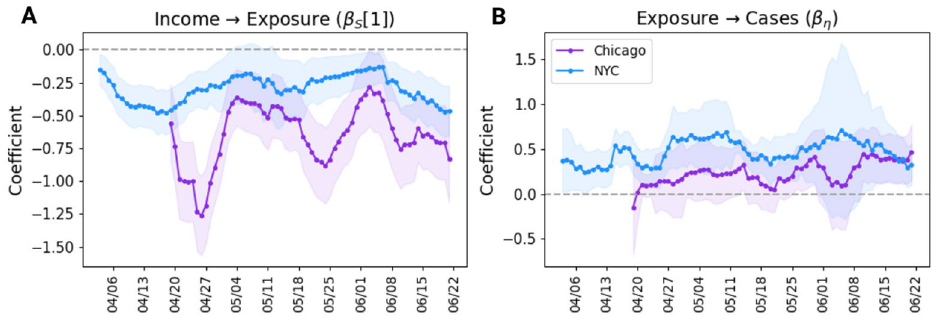
Figure 4. Estimates of important parameters of daily SEMs. Daily series of coefficient estimates of the two SEM relationships of interest for Chicago and NYC shown as 7-day moving averages: ( A ) effect of income on exposure, and ( B ) effect of exposure on new cases. The shaded region indicates the region spanned by estimate ± standard error.